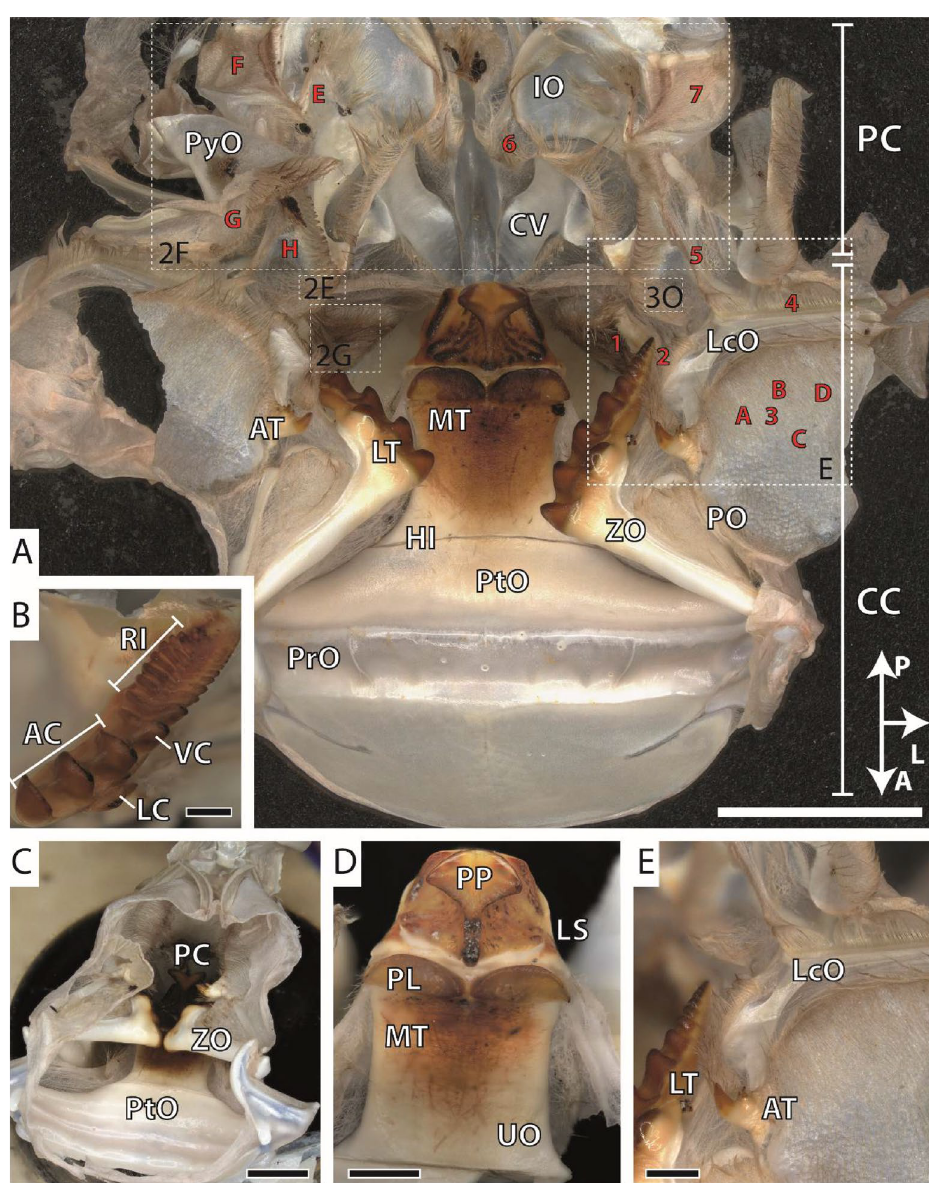
Figure 1. Light microscopy images from the gastric mill of Procambarus clarkii . ( A ) Dissected gastric mill (red letters highlight the localities of the tested membrane and red numbers—the localities of the tested setae; the arrow points in the anterior, posterior, and lateral directions. ( B ) Lateral tooth. ( C ) Gastric mill with interacting lateral teeth. ( D ) Medial tooth. ( E ) Accessory tooth. A anterior, AC anterior cusp of the lateral tooth, AT accessory tooth, CC cardiac chamber, CV cardiopyloric valve, HI hinge of medial tooth, IO inferior ampullary ossicle, L lateral, LC lateral cusp of the lateral tooth, LcO lateral cardiac ossicle, LS lateral spines of medial tooth, LT lateral tooth, M membrane, MT medial tooth, P posterior, PC pyloric chamber, PL plate of the medial tooth, PO pectineal ossicle, PP posterior process of the medial tooth, PrO prepterocardiac ossicle, PtO pterocardiac ossicle, PyO pyloric ossicle, RI ridges of the lateral tooth, S setae, UO urocardiac ossicle, VC ventral cusp of the lateral tooth, ZO zygocardiac ossicle. Scale bars: A, 3000 µm; B, 400 µm; C, 2000 µm; D, 1 mm; E, 800